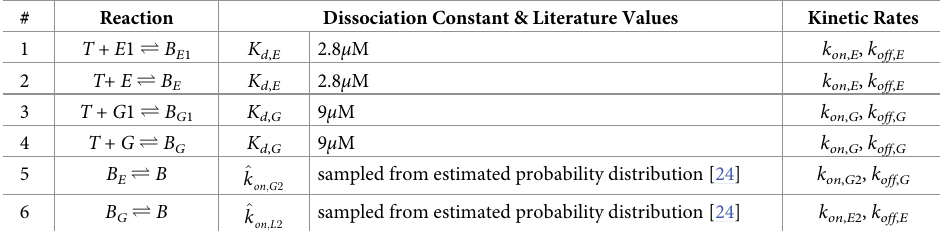
Table 1. Bivalent binding reactions and kinetic